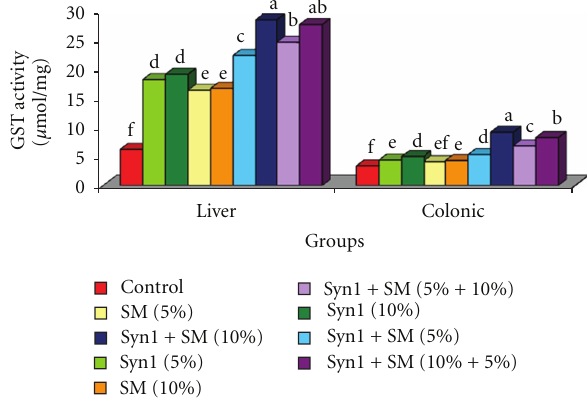
Figure 3: E ff ect of feeding prebiotics and soybean meal on (a) hepatic GST (b) colonic GST activity ( μ mol/mg) in F344 male rats. Abbreviations: SM: soybean meal, GST: glutathione-s-transferase. Values are expressed as means ± SEM. abcdef Bars with same letter are not significantly di ff erent using Tukey’s studentized range test ( P ≤ 0 . 05).